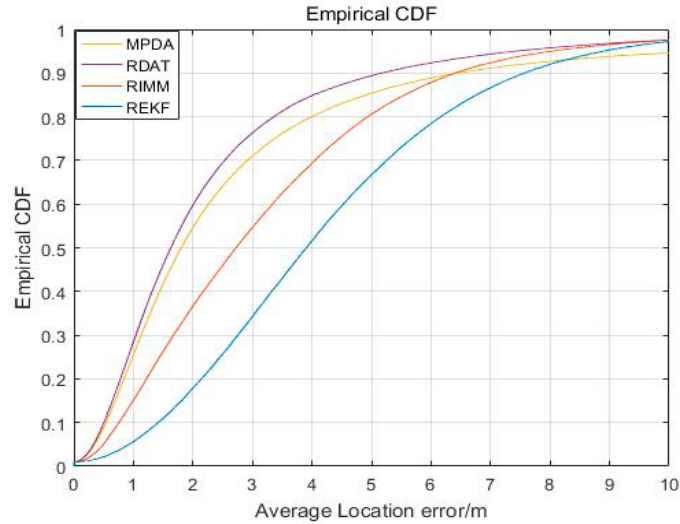
Figure 5. Performance contrast of RIMM, REKF, MPDA, and RDAT with di ff erent standard deviation of NLOS errors σ NLOS , P NLOS = 0.5, N